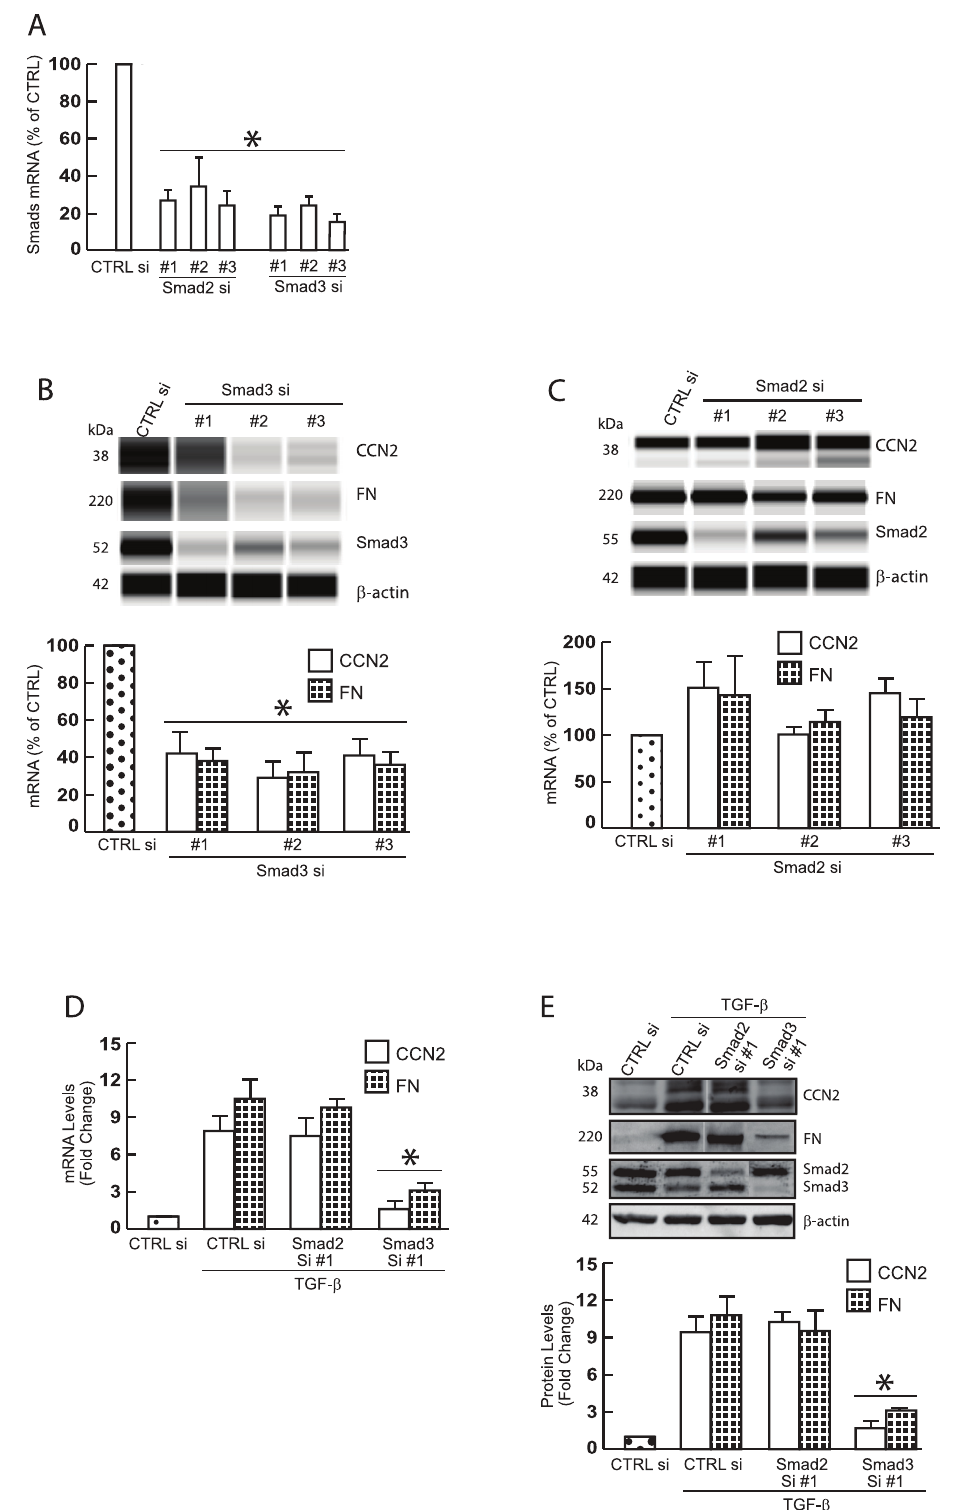
Fig 3. CCN2 and FN expression are primarily regulated by Smad3 in primary dermal fibroblasts. Primary dermal fibroblasts(1 × 10 6 ) were transfected with the indicatedsiRNAs (20nM). Total RNA and whole cell extract were prepared48 hours after transfection. mRNA levels were quantified by real-time RT-PCR. Protein levels were determined by ProteinSimple capillaryelectrophoresis immunoassay (B, C) and Western